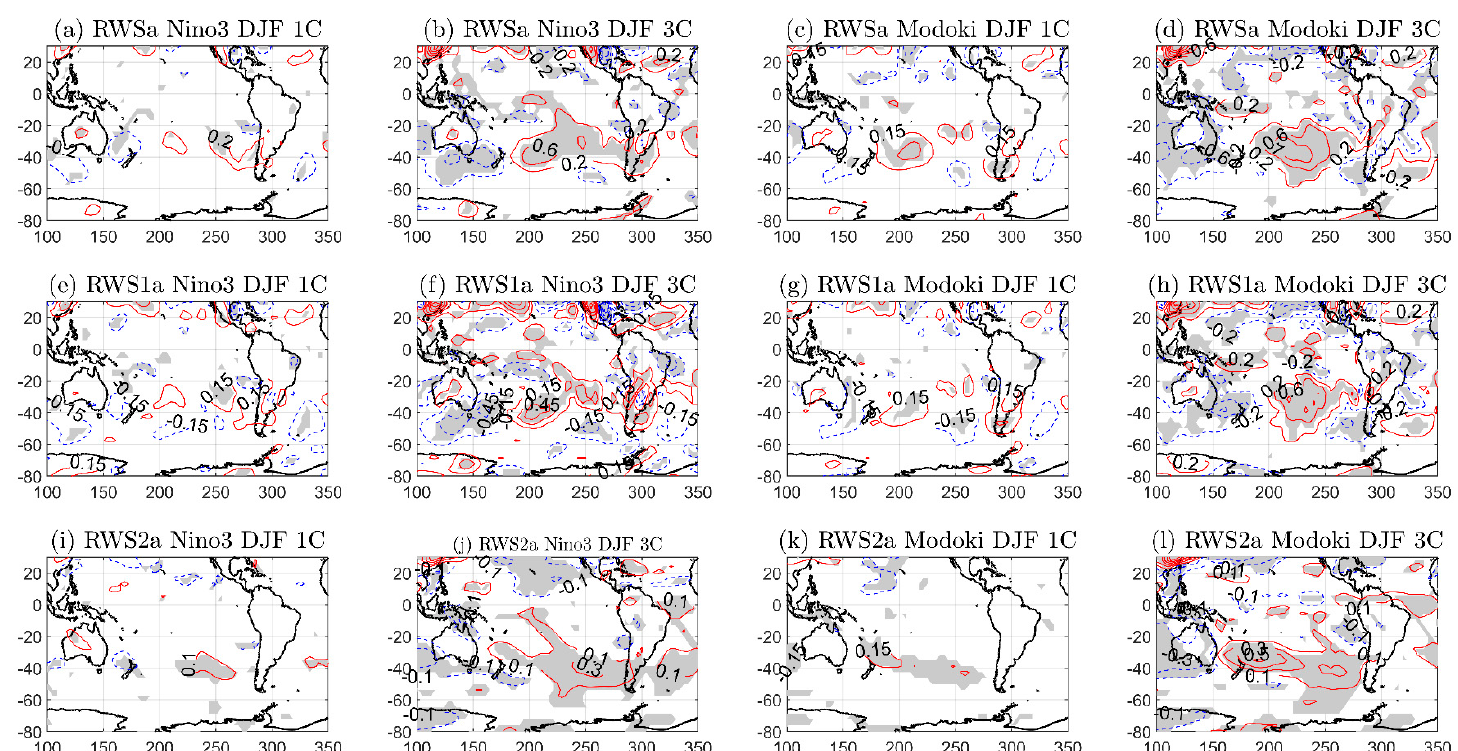
Figure 6. Composite maps of the Rossby Wave Sources (RWS)a (s − 2 ). First and third columns show results for Canonical_1C and Modoki_1C experiments, respectively. Second and fourth columns show the results for Canonical_3C and Modoki_3C experiments. In ( a – d ) the whole RWS field is shown. ( e – h ) shows the vortex stretching term (RWS1), and ( i – l ) the advection of absolute vorticity by the divergent wind flow (RWS2). Values are multiplied by the scale factor 10 − 10 . Shaded regions exceeded the 95% level of confidence from two-tailed t -test.